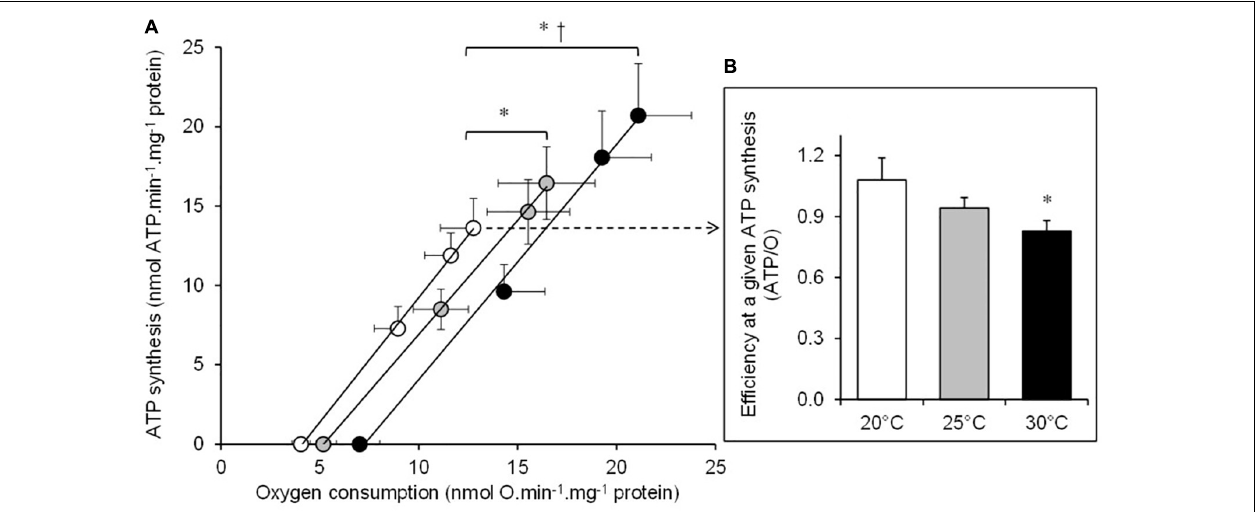
FIGURE 1 | The effect of temperature on the mitochondrial oxidative phosphorylating efficiency. (A) The rates of ATP synthesis and oxygen consumption were determined at 20 ◦ C (white circles), at 25 ◦ C (gray circles), and at 30 ◦ C (black circles) in the mitochondria isolated from the liver of toad and respiring on succinate. Mitochondrial fluxes were titrated with increasing concentrations of ADP in the presence of glucose and hexokinase (see section “Materials and Methods” for more details). Values are means ± SEM for N = 5 independent mitochondrial preparations. (B) The coupling efficiency calculated at the highest common ATP synthesis rate between the three temperatures (13.6 nmol ATP min − 1 mg − 1 protein). Shortly, oxygen consumption rates were calculated at this highest common ATP synthesis rate by using individual linear relation curves. Then, the resulting effective ATP/O ratios were calculated at 20 ◦ C (white bars), at 25 ◦ C (gray bars), and at 30 ◦ C (black bars). The values are means ± SEM for N = 5 independent mitochondrial preparations. * and † mean significantly different from 20 and 25 ◦ C, respectively ( p <